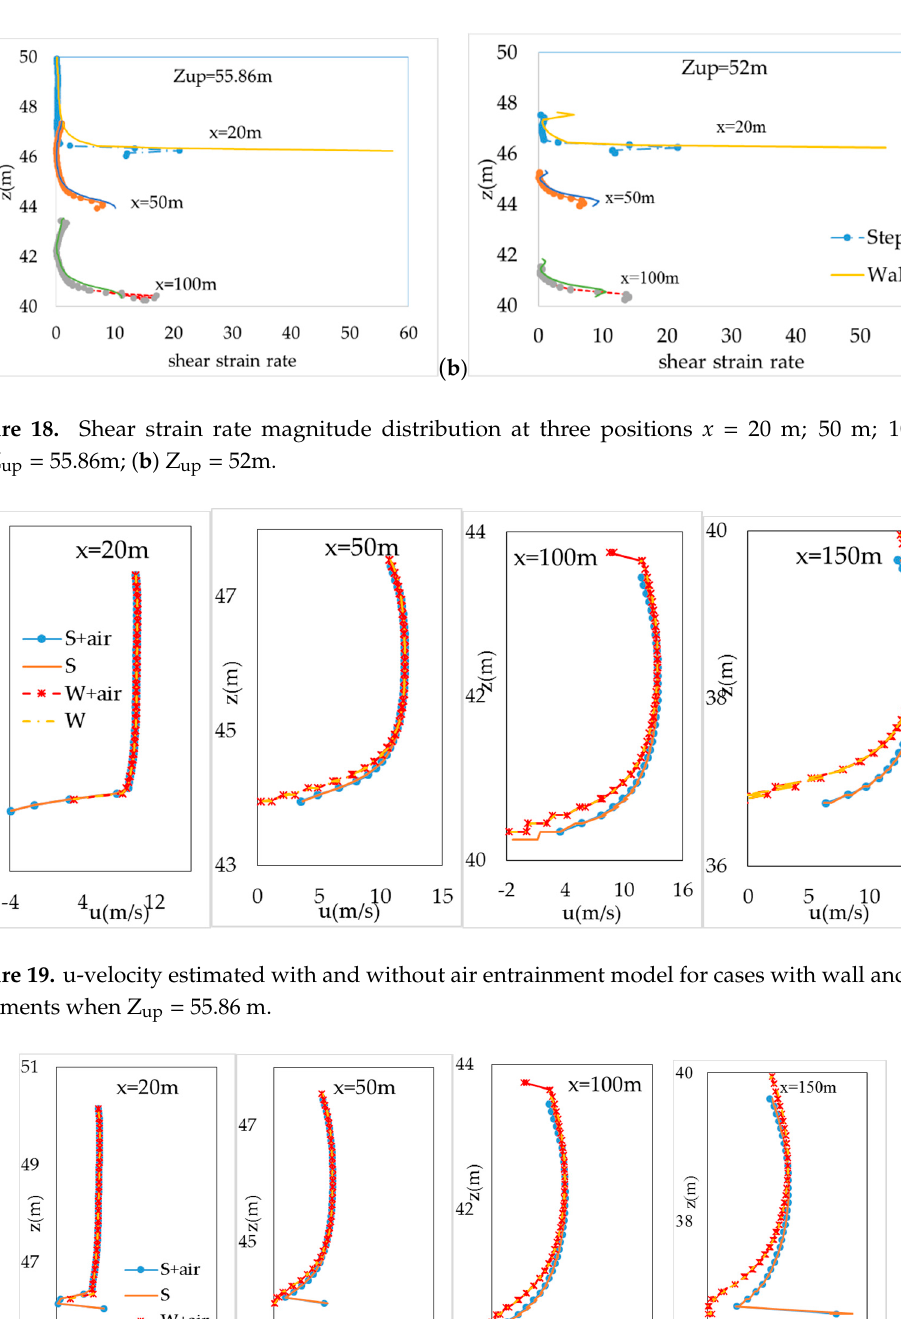
Figure 17. Strain rate magnitude for two abutment types when Z up = 55.86 m and Q = 3319 m 3 /s.